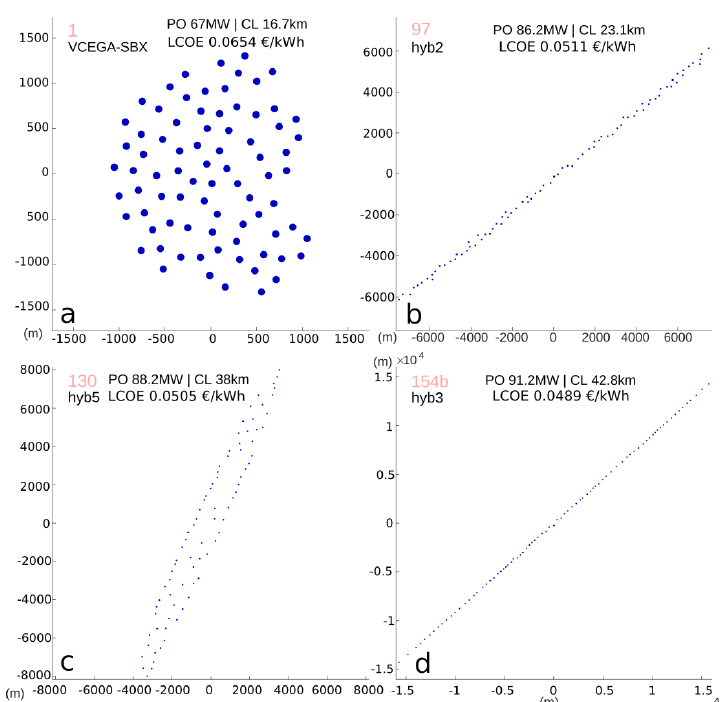
Figure 9. Samples of solutions throughout the obtained aggregated Pareto front in the final generation ( F agg ) holding LCOE extremes obtained for a decision maker in Denmark: ( a ) max. LCOE (and minimum Cable Length), ( b ) similar PO as baseline, ( c ) min. LCOE (and max. PO) with max. WF length constraint and ( d ) min. LCOE (and max. PO) without max. WF length constraint. Numbers in pink stand for its sorting positions in the F agg (from min. CL to max PO). Circles represent the turbine rotors proportional to their relative size.